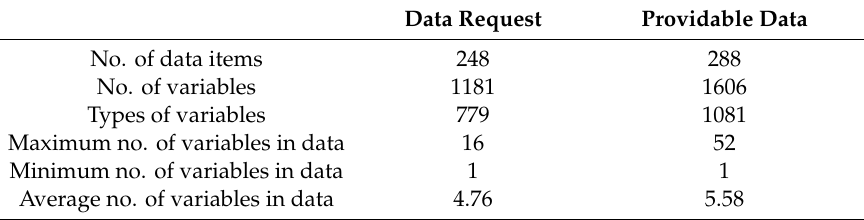
Table 2. Characteristic values of data requests and providable data with